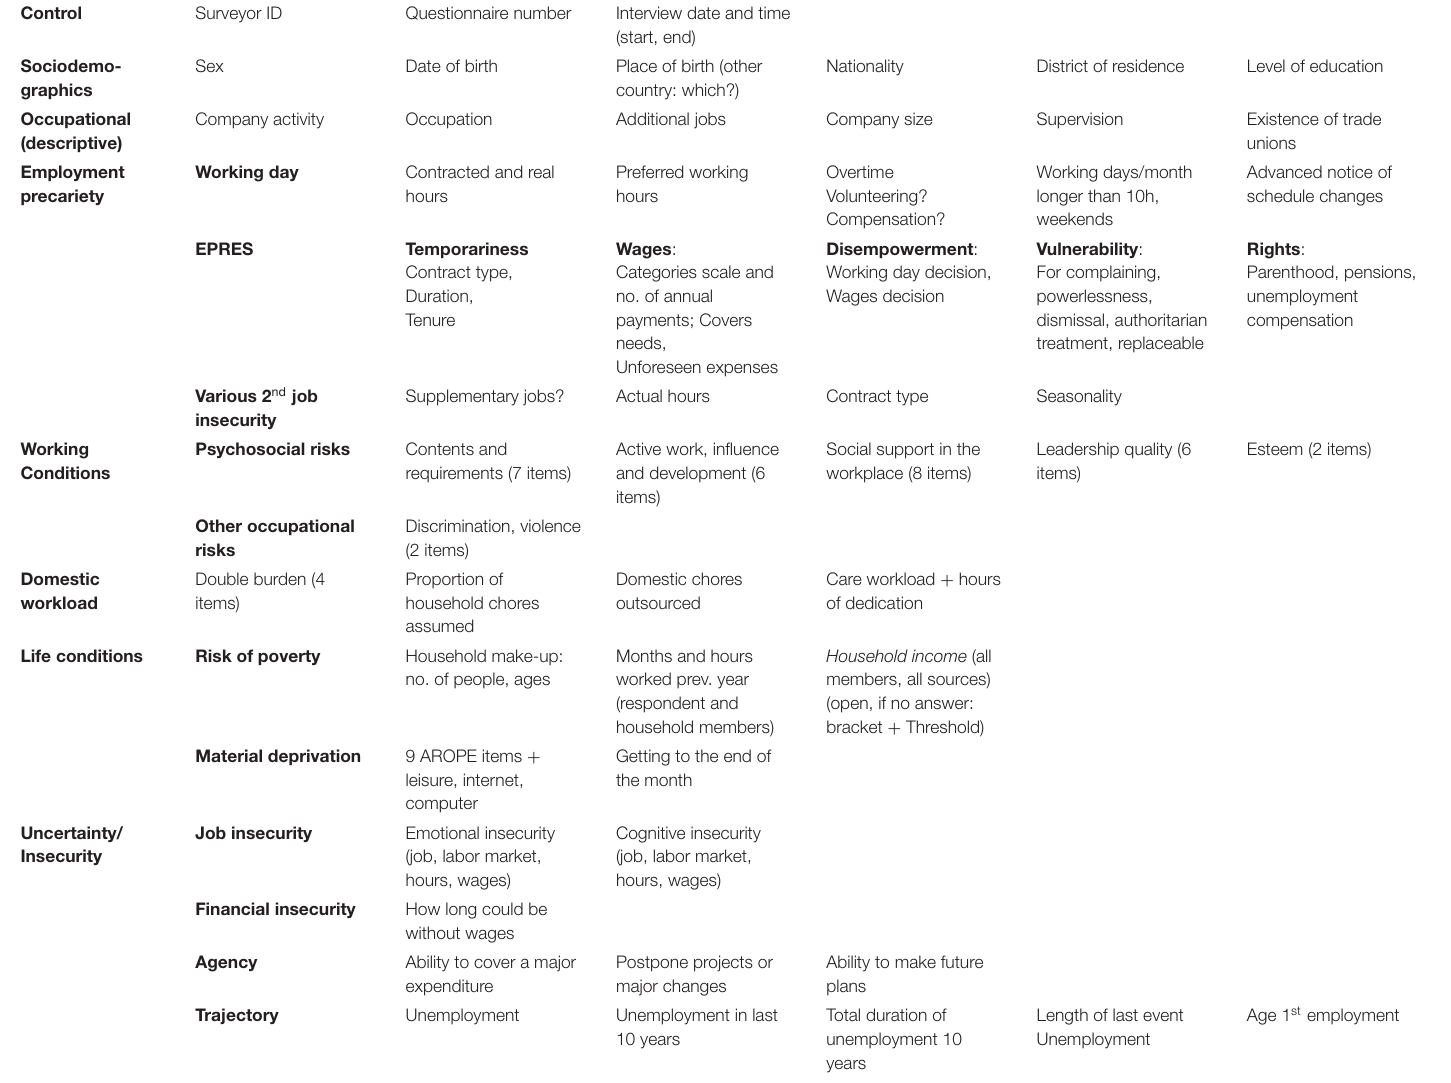
TABLE 2 | Detail of the variables included in the PRESSED survey